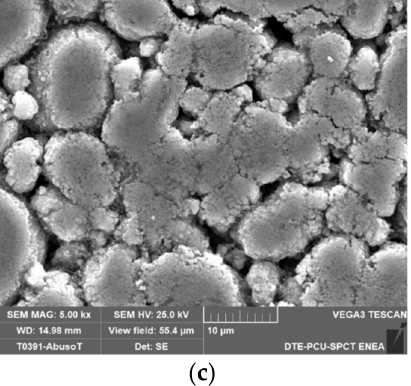
Figure 9. SEM images with a 5000x magnification of the cathode of the graphite-based anode cell: ( a ) new, ( b ) overdischarged with a DOD% = 110%, ( c ) overdischarged with a DOD% = 140%.